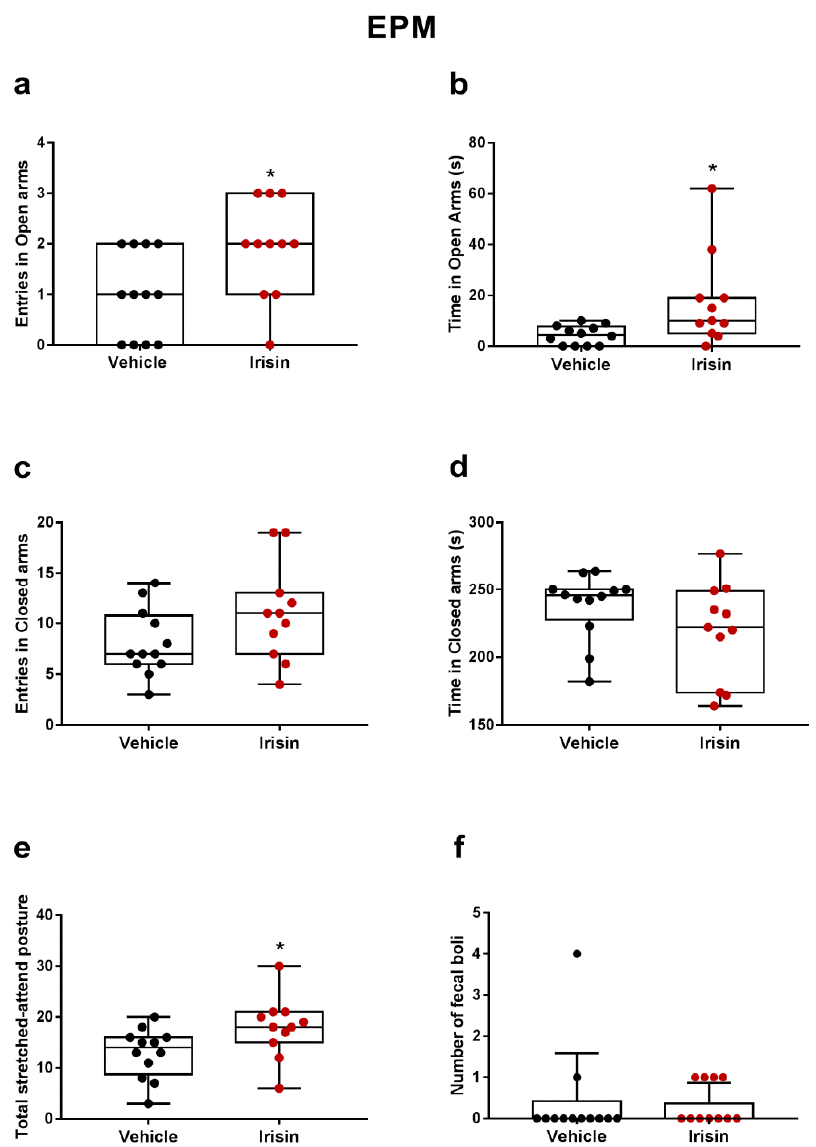
Figure 2. Effect of short-term systemic administration of irisin on the number of entries ( a ), time spent ( b ) in open arms, number of entries ( c ), time spent ( d ) in closed arms, total stretched-attend posture ( e ), and number of fecal boli ( f ) in the EPM. Shapiro–Wilk test and unpaired Mann–Whitney test were used for statistical analysis. Data are presented as box-and-whisker with median and interquartile ranges, from max to min, with all data points shown. n = 12 vehicle-treated mice and n = 11 irisin-treated mice. * p <